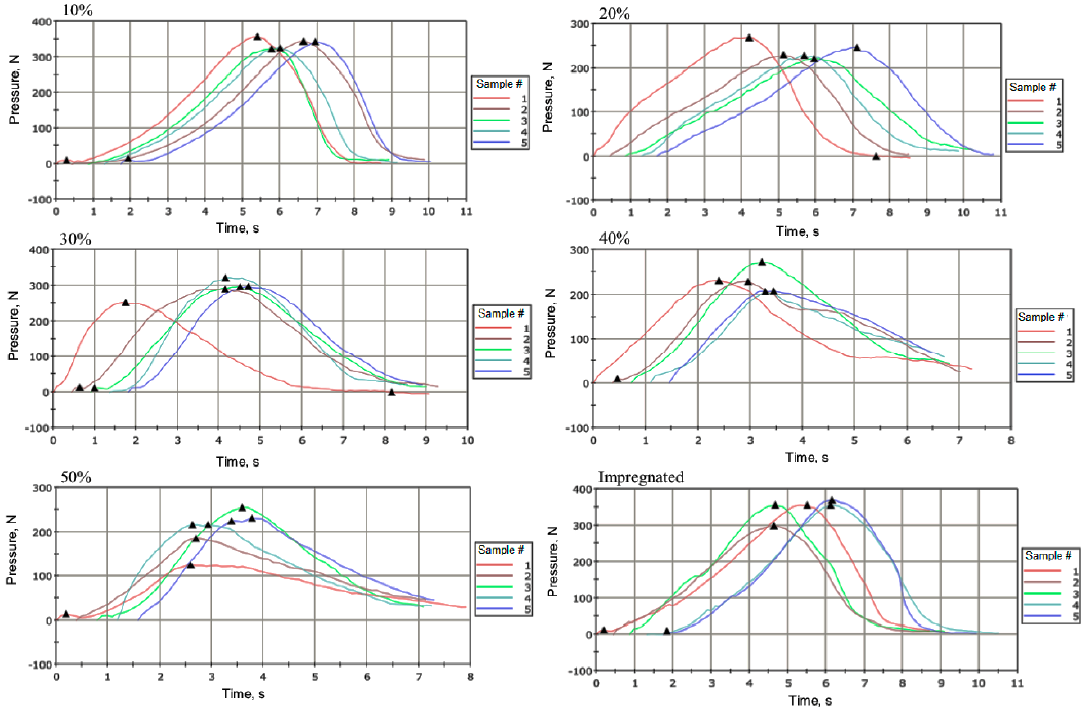
Figure 3. The response to the compressive load of carbonized refuse-derived fuel (CRDF) pellets (all produced at 50.8 MPa), with a 10% to 50% water glass content as a binder addition or with water glass as a coating. Black triangles signify the crack point of the pellet sample, and thus the maximum compressive strength of the densified material.